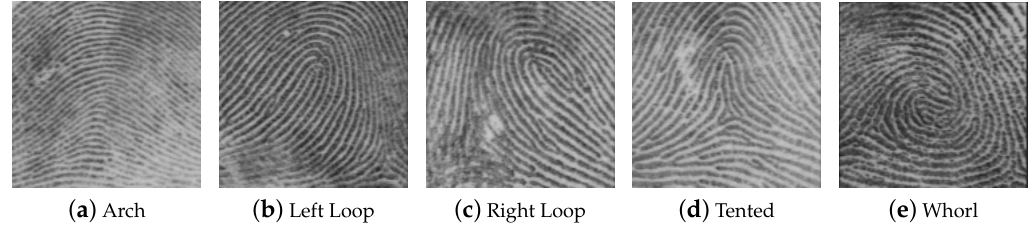
Figure 2. The five types of fingerprints defined by Henry (source